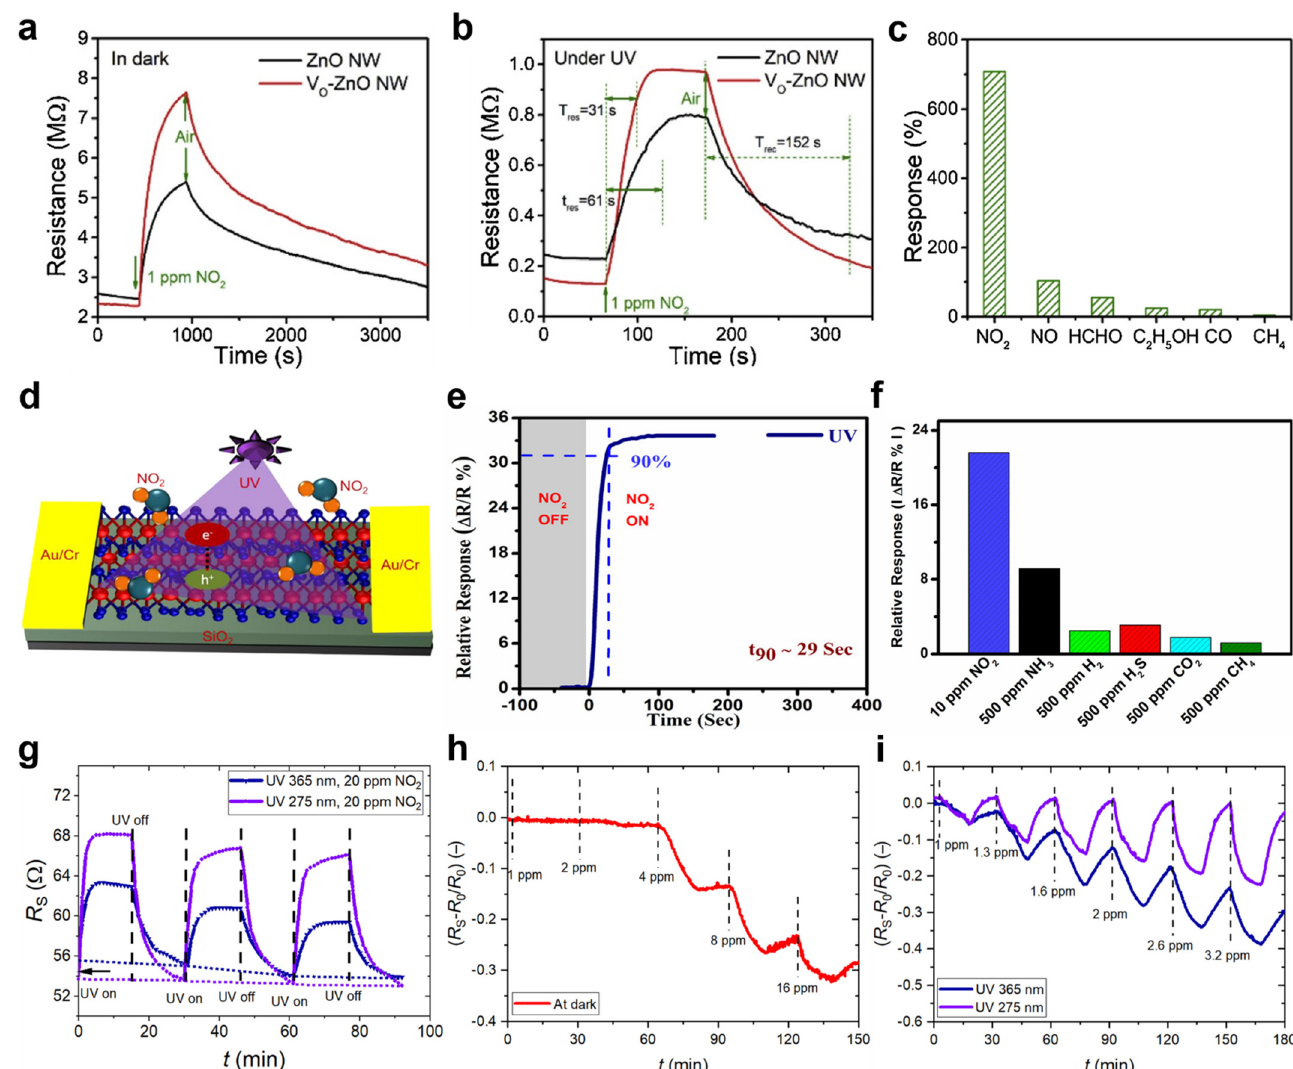
Figure 3. Resistance changes in the ZnO NW sensor and the Vo − ZnO NW sensor ( a ) under dark ( b ) under UV irradiation; ( c ) gas selectivity characteristics of the Vo − ZnO NW sensor (adapted from [87] with permission from the Elsevier B.V.); ( d ) schematic diagram of the MoS 2 − based gas sensor; ( e ) response time of the MoS 2 − based gas sensor under UV irradiation; ( f ) selectivity histogram of the MoS 2 − based gas sensor (adapted from [88] with permission from the American Chemical Society); ( g ) response of the CNN sensor with UV lights irradiation ( λ = 365, 275 nm); ( h ) response of the CNN sensor under the dark condition; ( i ) response of the CNN sensor under UV irradiation (adapted from [89] with permission from the Elsevier